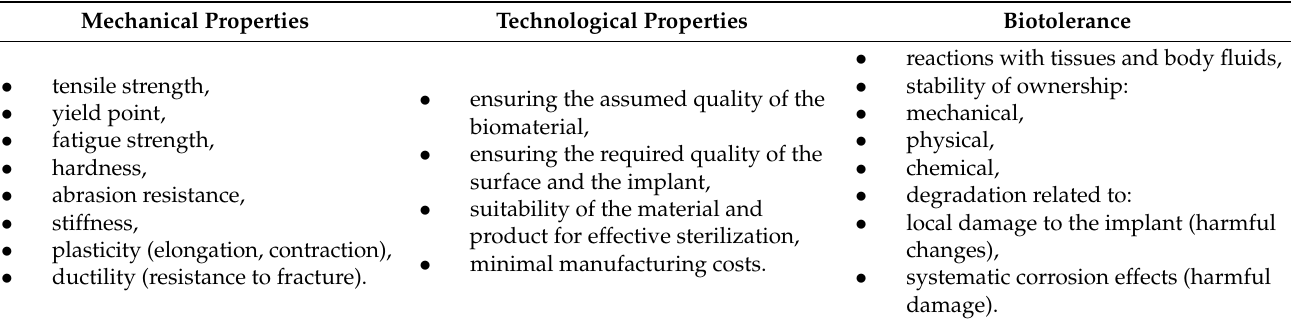
Table 1. Examples of requirements for materials used for surgical